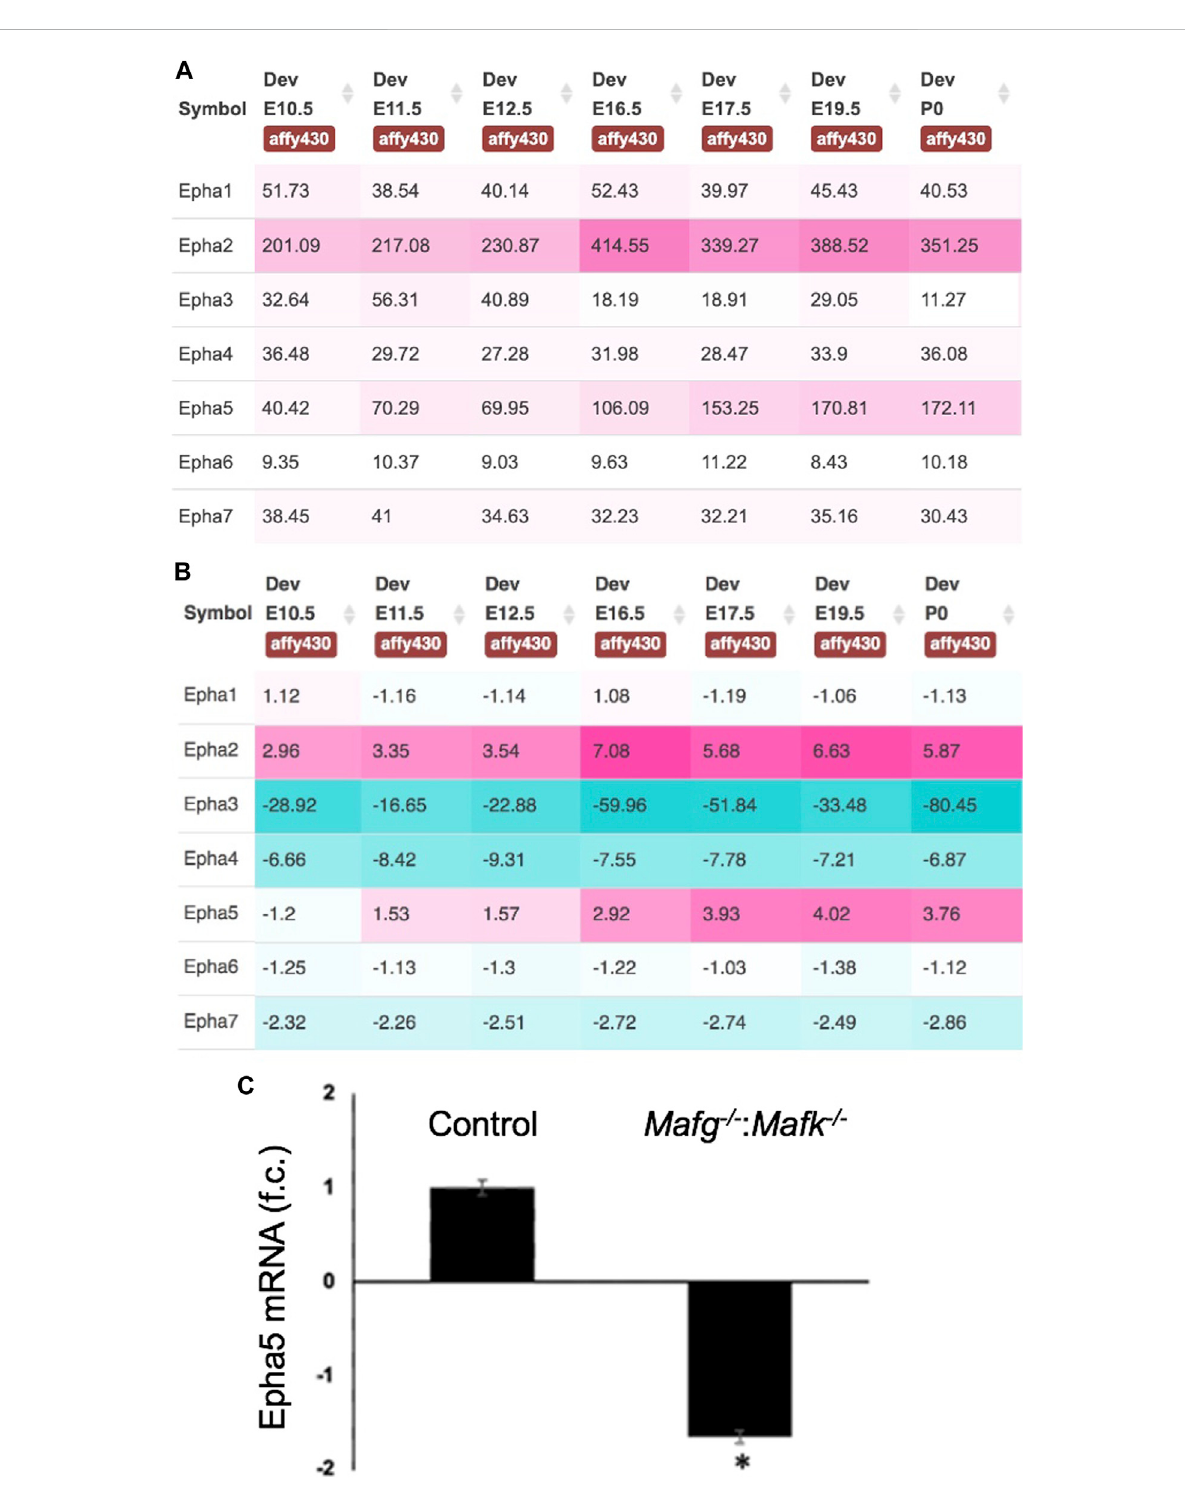
FIGURE 8 Expression of Eph-signaling receptors in normal lens development and the reduced expression of Epha5 in Mafg − / − : Mafk − / − lens. (A) iSyTE analysis of various Eph-signaling receptors shows that Epha5, which is identi fi ed by RNA-seq analysis among the DEGs in Mafg − / − : Mafk − / − lenses, exhibits high expression and (B) high lens-enriched expression, second only to Epha2 that is linked to congenital cataract in humans and in animal models. (C) RT-qPCR validation of abnormally reduced expression of Epha5 in Mafg − / − : Mafk − / − lenses. Numbers in (A) represent normalized microarrays fl uorescence intensity units as described in Kakrana and coworkers (2018). Fold-change was calculated using the ΔΔ CT-method using Gapdh as a house-keeping gene and statistical signi fi cance was determined using a two-sample Student ’ s t -test. Asterisk indicates p ≤